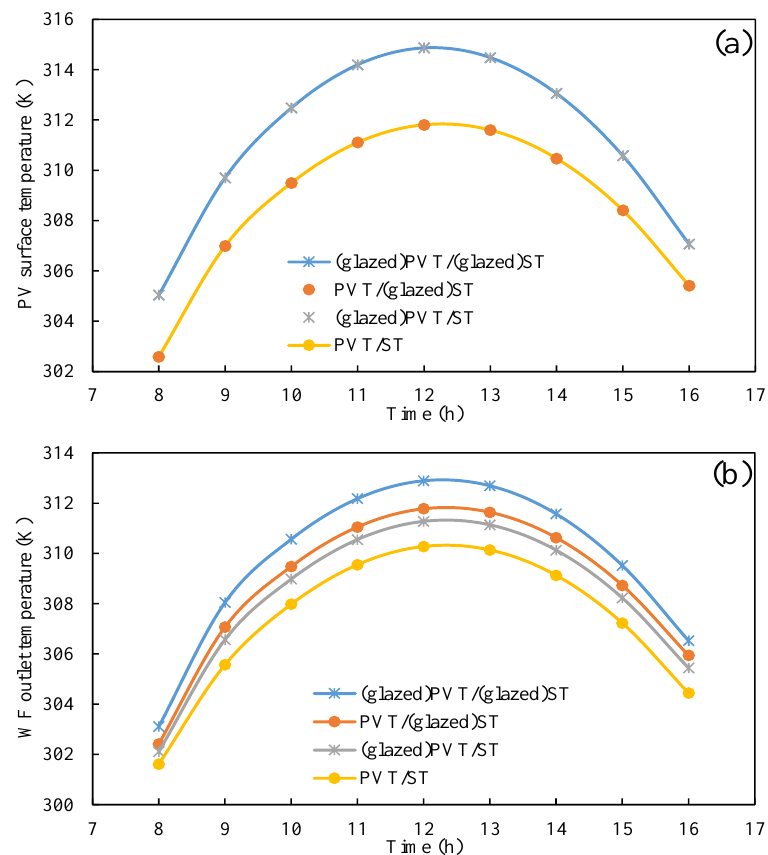
Fig. 11. Temporal variations of the (a) PV surface temperature and (b) WF outlet temperature for different PVT/ST with and without glass cover on various parts at the mass flow rate of 50 kg/h during a day in